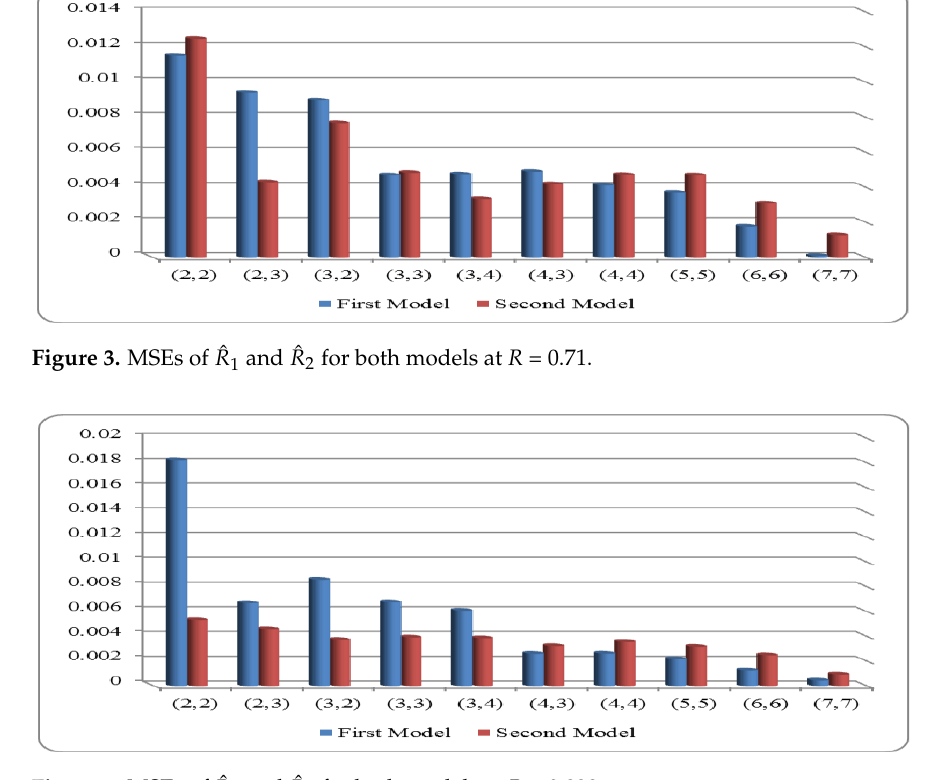
Figure 4. MSEs of Figure 4. MSEs of